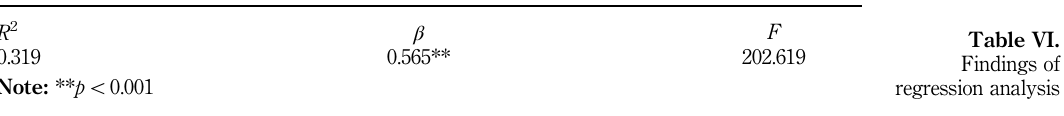
Table V. Year of study findings on language used and citation of information